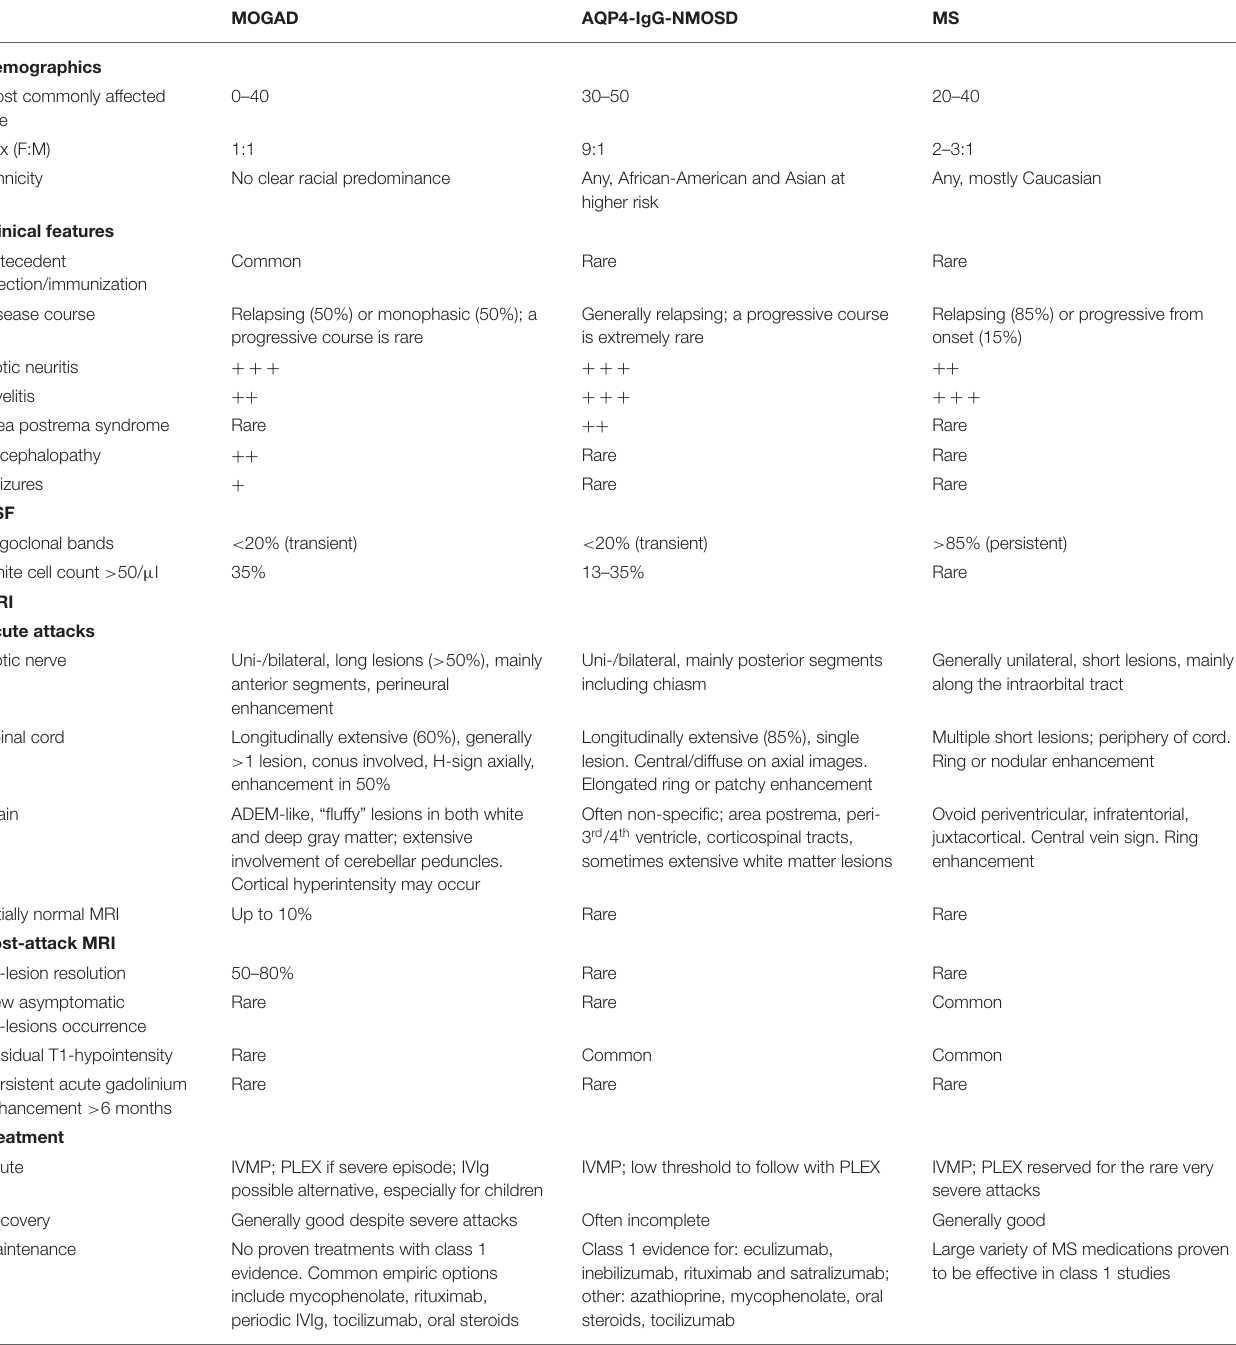
TABLE 1 | Comparison of demographics, clinical, laboratory and MRI characteristics in MOGAD compared to AQP4-IgG + NMOSD, and